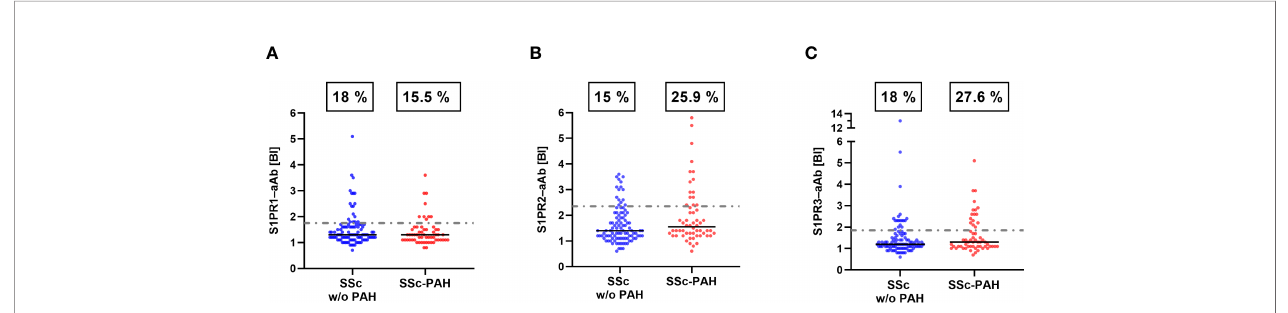
FIGURE 4 | Prevalence of S1PR – aAb in SSc patients as a function of a diagnosis of PAH. SSc patients were subdivided into those with or without a diagnosis of PAH. (A) Prevalence of S1PR1-aAb was similar in both groups of patients, whereas (B) the prevalence of S1PR2-aAb was higher in SSc patients with PAH than in patients without PAH (P<0.05). (C) The difference in prevalence of S1PR3-aAb between both groups did not reach statistical signi fi cance (P>0.05). The binding indices (BI) along with the percentages of positive samples are provided. Prevalence was compared by one-sided Chi square test.